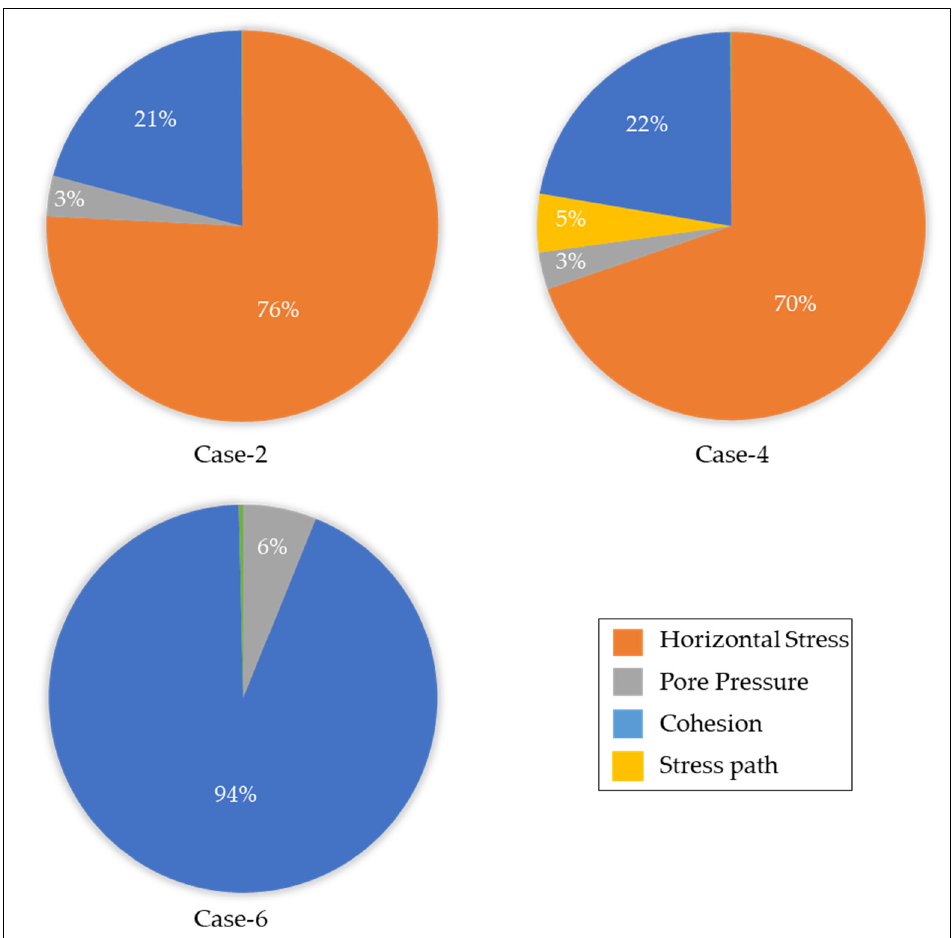
Figure 9. Square of the sensitivity factor ( α 2 ) shows the contribution of each parameter to the prob- ability failure output in the lower Drake unit. The relative importance varied between cases.